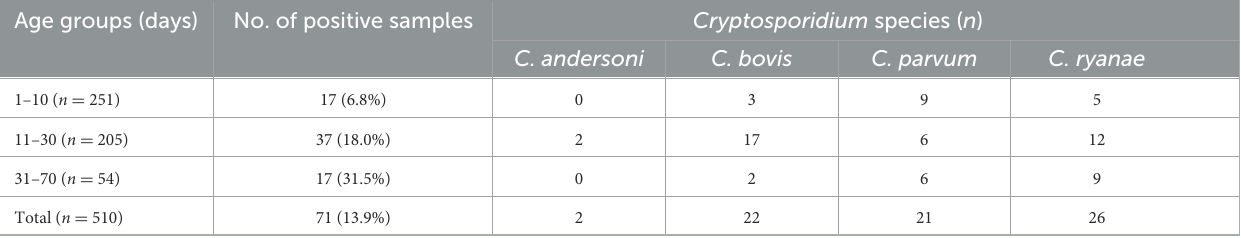
TABLE 2 Positivity of Cryptosporidium spp. according to age group in pre-weaned calves with diarrhea in the ROK. Age groups